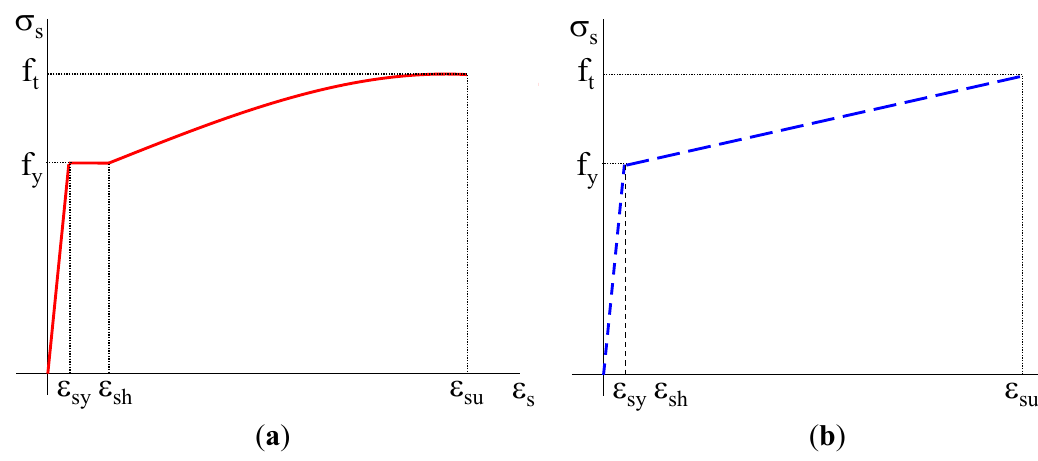
Figure 5. Alternative stress-strain laws for steel reinforcing bars: “accurate” ( a ) and “simplified” ( b ) bilinear